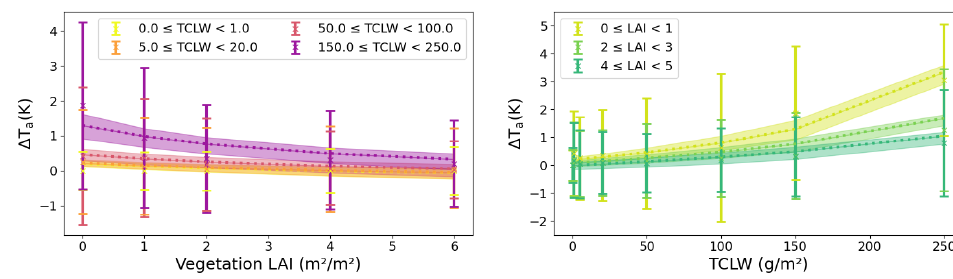
Figure 5. Average difference of T a from ERA5 data from the month of January, May and September 2016 as solid lines (with 1 standard deviation) as a function of the leaf area index (LAI) ( left ) and total column liquid water (TCLW) ( right ). On each plot different colors are used for bins of TCLW ( left ) and LAI ( right ). The dotted lines show the predicted values of ∆ T a by the parameterization with the same input, and the shaded area shows the 1 σ uncertainty on the fitted